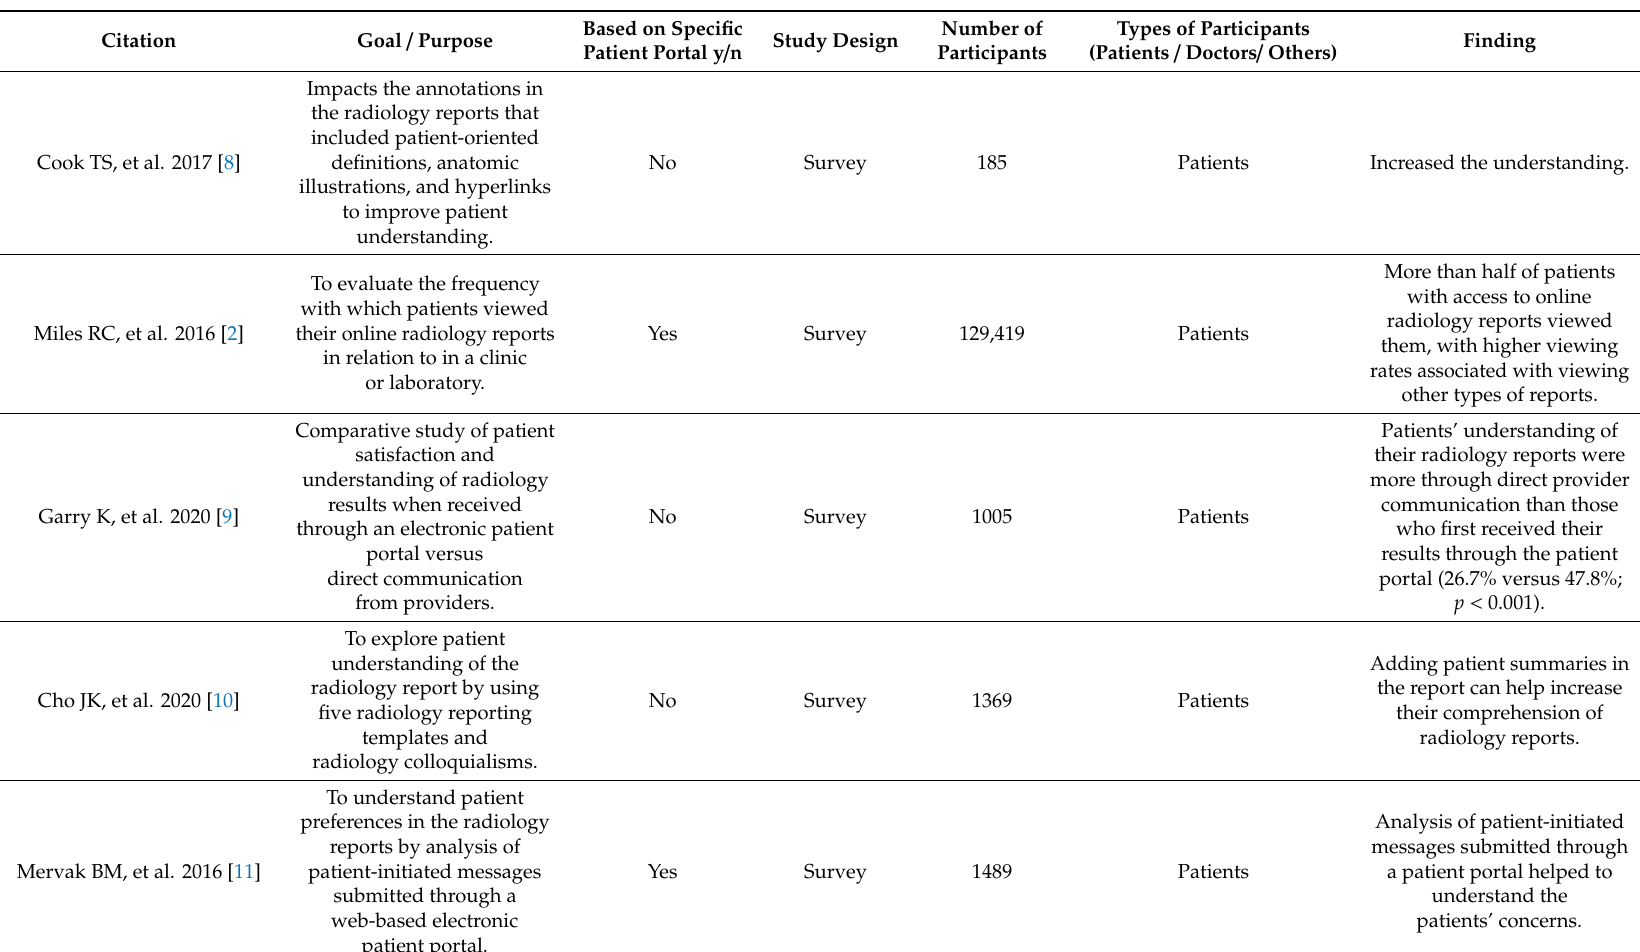
Table 1. Detailed references of the patient portals and the radiology report in the reviewed